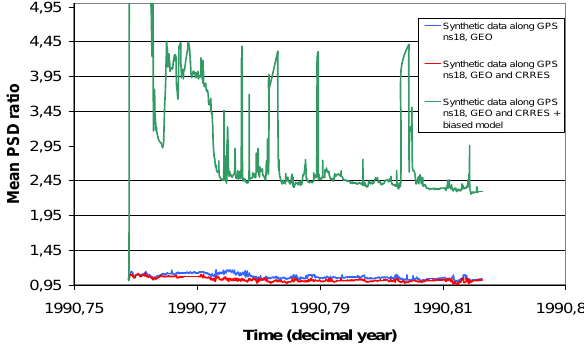
Fig. 11. Mean ratio over the full simulation grid of the mean pre- dicted PSD by the ensemble to the “true” PSD versus time in an identical-twin configuration. Comparison when a non biased or bi- ased assimilating model is